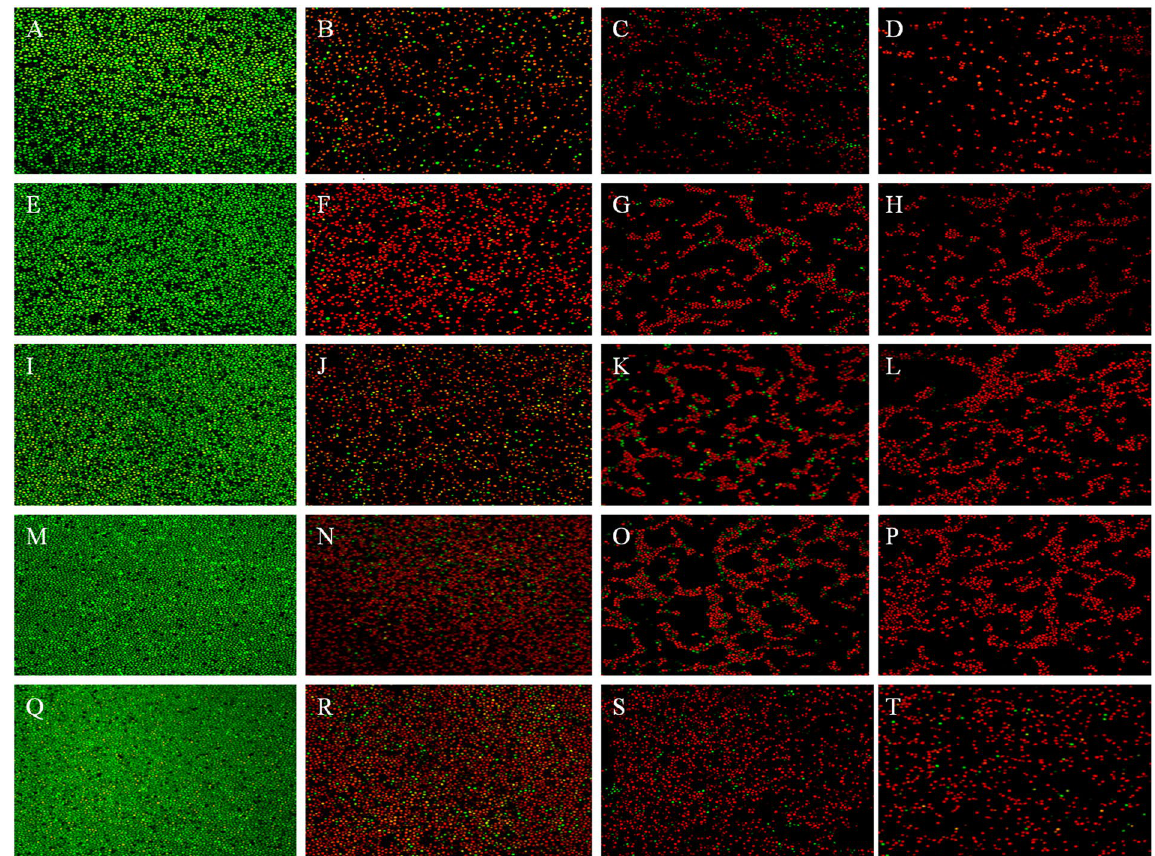
Figure 7. Live/dead staining of fungal biofilms on PMMA resin ( × 40). The transverse direction rows are the control ( A,E,I,M,Q ), 0.1 wt% ( B,F,J,N,R ), 0.2 wt% ( C,G,K,O,S ), and 0.3 wt% ( D,H,L,P,T ) groups, and the longitudinal direction columns are is the groups aged 0 w ( A,B,C,D ,), 1 w ( E,F,G,H ), 2 w ( I,J,K,L ), 3 w (M,N,O,P ) and 4 w ( Q,R,S,T ). Live fungi were stained green, while dead fungi were stained red. Live/dead fungi that were close to or on top of each other produced yellow/orange colors. The control groups showed primarily live fungi. The AgBr/NPVP-containing PMMA resin showed substantial fungal activity.